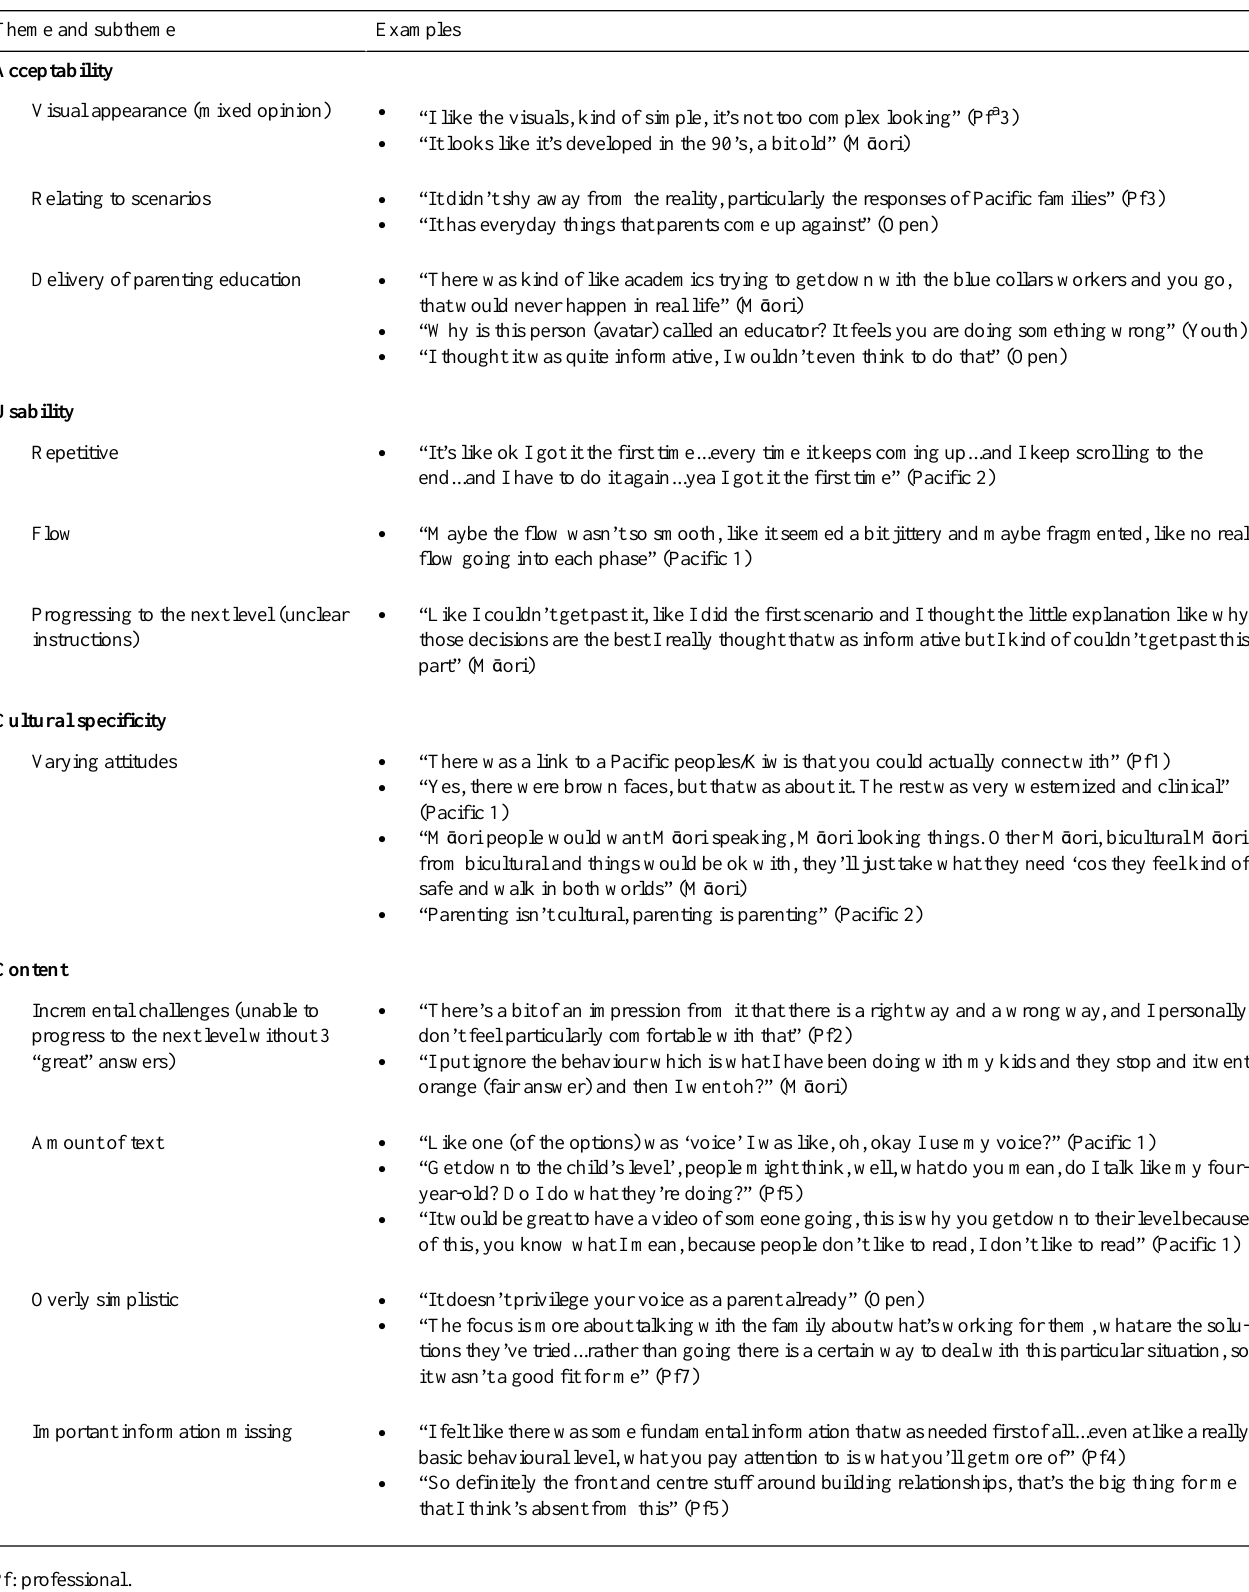
Table 3. Major themes, subthemes, descriptions, and examples from the